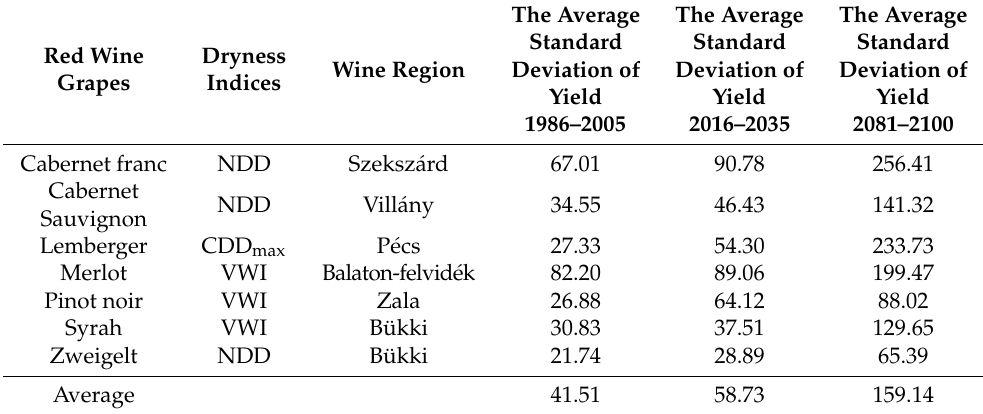
Table 12. Values of standard deviations of estimated white wine grape yields were produced based on the regression coefficients of the best regression fits of dryness indices in different 20-year periods. Standard deviation is significantly more substantial in the distant future compared to the recent past. Only two cultivars expect a significant increase in standard deviation for the near future, set in